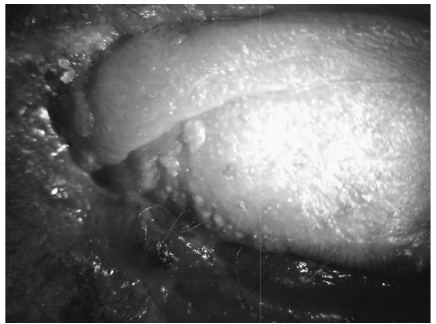
Figure 1: Vesicular lesions on the left upper eyelid.